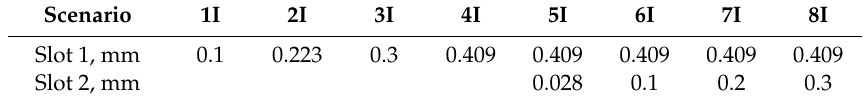
Figure 2. The geometry of the simulated beam with indication of the damage location. Table 1. The damage scenarios for the damage identification.